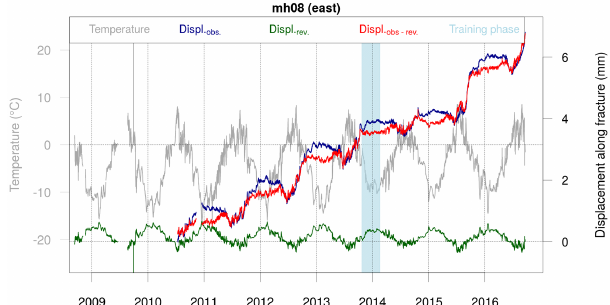
Figure A2. Linear regression model (LRM; green) applied to the observed displacements (blue) along the fracture at location mh08 . The reversible component (green) due to thermoelastic strains in rock can be modeled by a LRM with temperature as input data (dark gray) and displacement measurements during a training pe- riod of several months (light blue shading). Subtracting these re- versible displacements from the observed data results in the red line, referred to as irreversible fracture displacement.